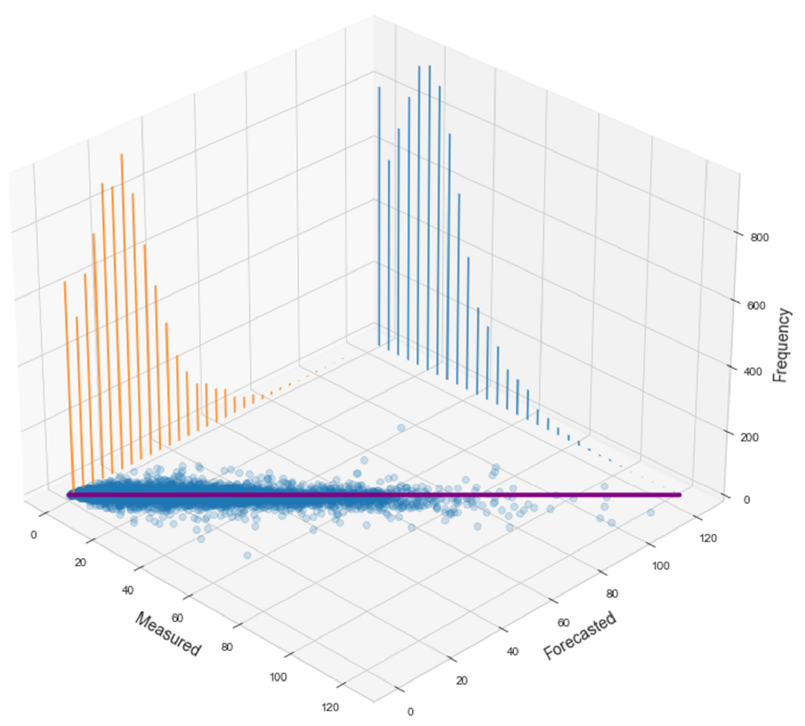
Figure 8. Scatter plot with marginal distribution for GraphSAGE model forecasting ozone 1 h ahead.